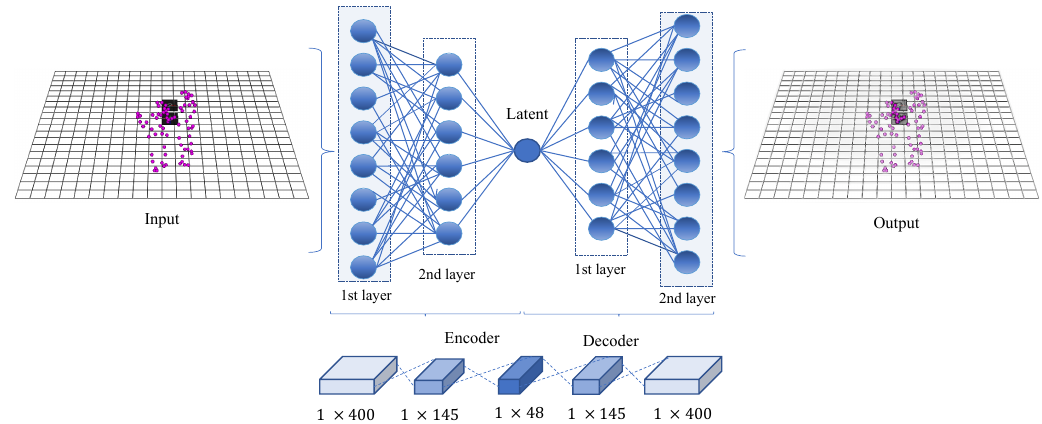
Figure 4. The structure of the proposed auto-encoder used for dimensionality reduction of the raw input